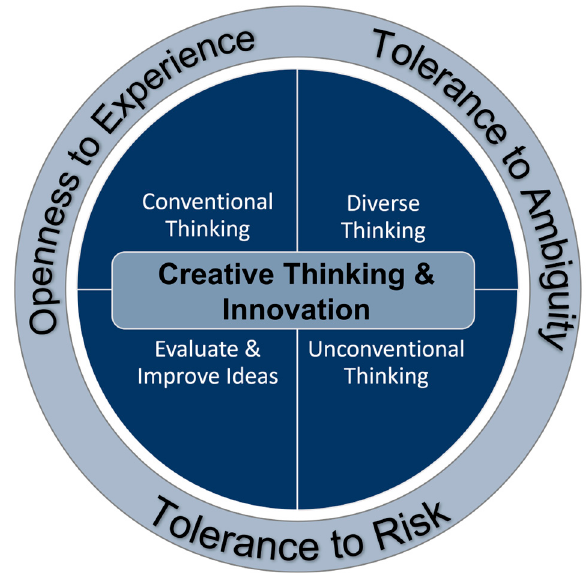
Figure 1. Creative Thinking and Innovation Framework.